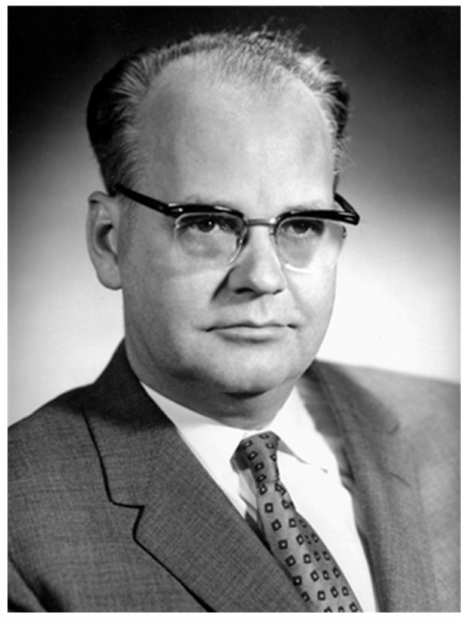
Figure 11. Gunnar Jungner, 1960, aged 46